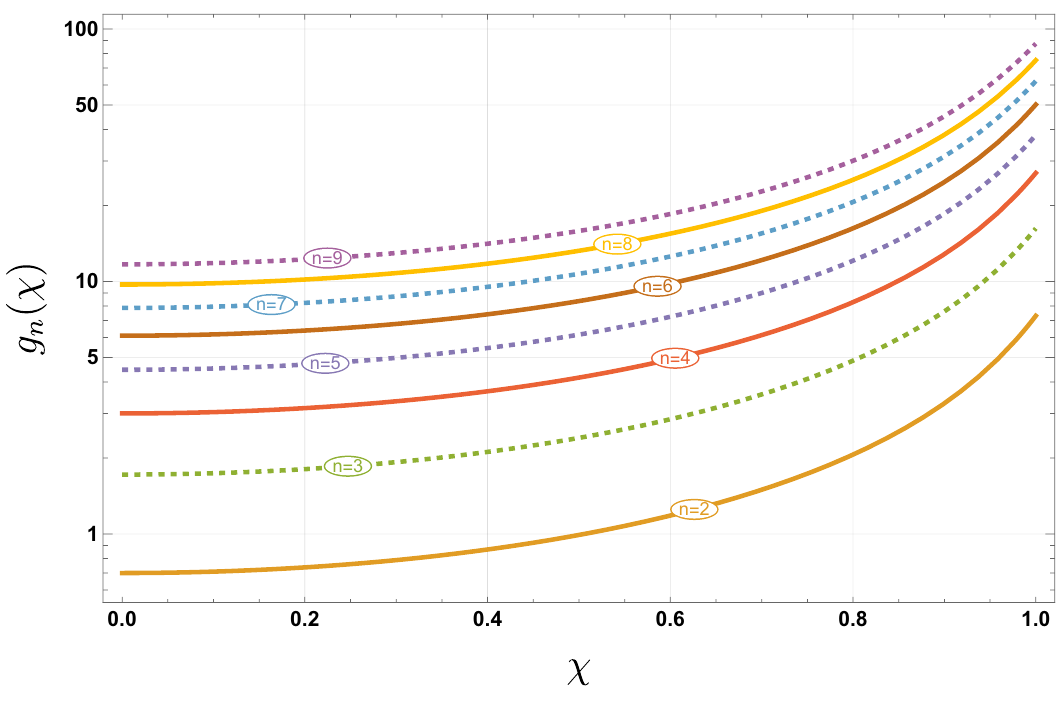
Figure 5 . The relative corrections to the multipole moments g n associated to the stringy corrections (cid:15) 1 = (cid:15) 2 , (cid:15) 3 = 0 , defined in (4.17). Note that we use a log scale in the vertical axis. We observe that in this case there seems to be no distinction between odd and even n ; the different curves seem to follow a single pattern with n